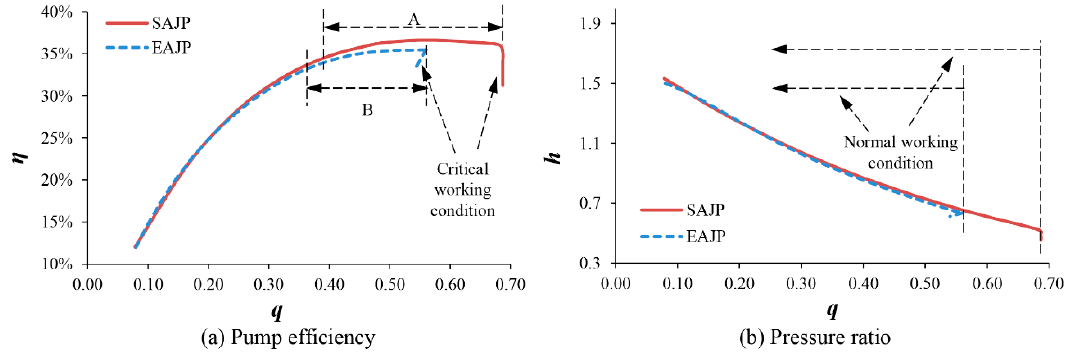
Figure 6. Performance curves. Table 2. Comparison of performance.